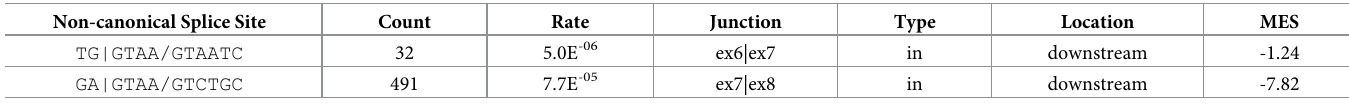
Table 3. Non-canonical 5’ splice site